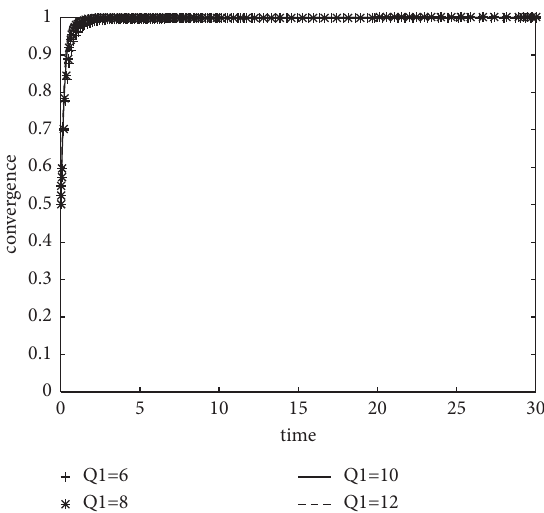
Figure 12: Changing the impact of Q